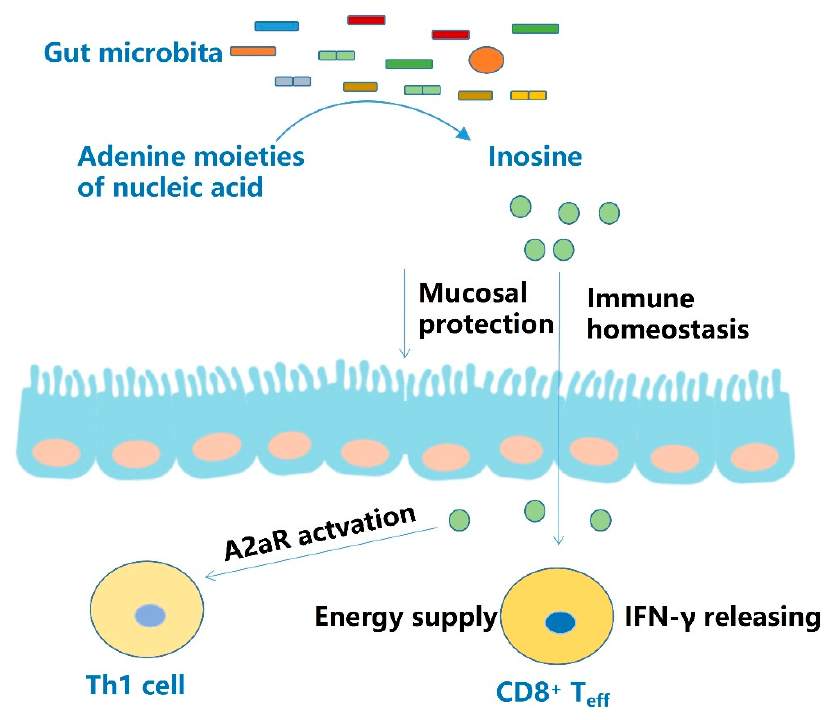
Figure 2. Effect and mechanism of inosine.